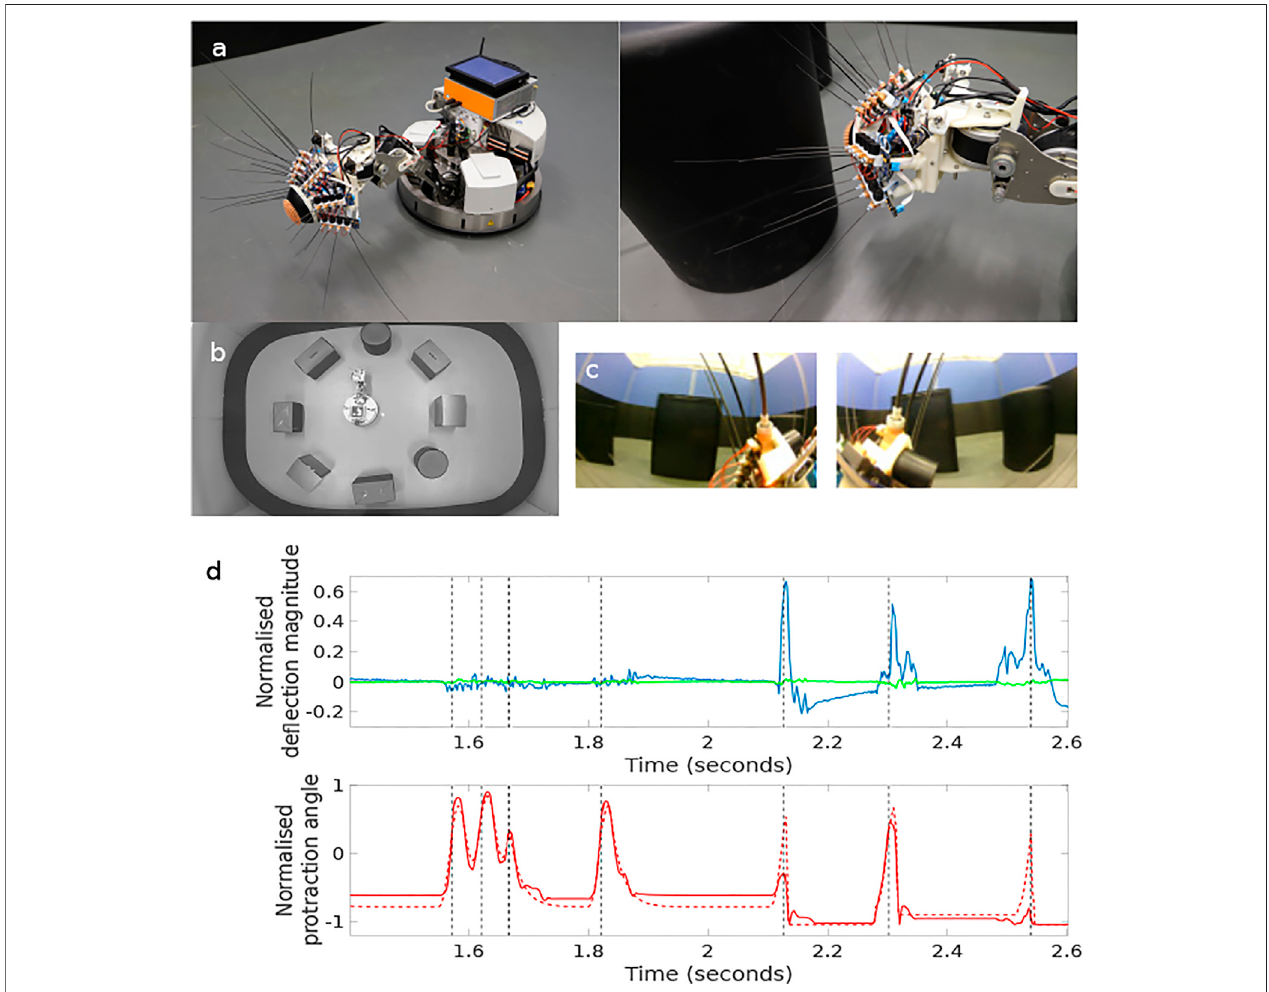
FIGURE1| TheWhiskEyerobot (A) has24actuated tactile whiskers and camera eyesonitsheadmountedat theenda3dofneckand omnidriveRobotinobody. Simultaneous visualframes[panel (C) , leftand righteye cameras] and tactile samplesare taken at thepoint ofpeak whisker protraction asindicatedby theblack vertical dashed lines in the plots of panel (D) . The example time series data shown in panel d are taken from a single whisker through 7 whisk cycles with only the fi nal 3 whisks makingcontactwithanobject.Thereddashedtraceinthelowerplotisthedriveordesiredprotractionangleofthewhiskerscaledto ± 1ofthefullwhiskanglerange of ± 80degrees ofrotation.The solidred lineisthemeasuredprotraction angle ofthewhisker ( θ whisk ) which canbe inhibited bycontacts asisclear on the fi fthwhisk.The blue traceintheupperplotisthe x -andthegreenthe y -de fl ectionofthewhiskerscaled to ± 1ofmaximumde fl ectionmagnitude. Thethreepositivewhiskercontactsare clearinthe fi nalthreewhisksofthissample.The x , y ,and θ whisk samplestakenatthepointofpeakprotractionforall24whiskersconstitutethetactile “ view ” oftherobotat thatinstance.Theexperimentalarenashowninpanel (B) ,waspopulatedwithmattblackcylindersandboxes,thecon fi gurationwaschangedbetweencollectingdatato train the networks and for